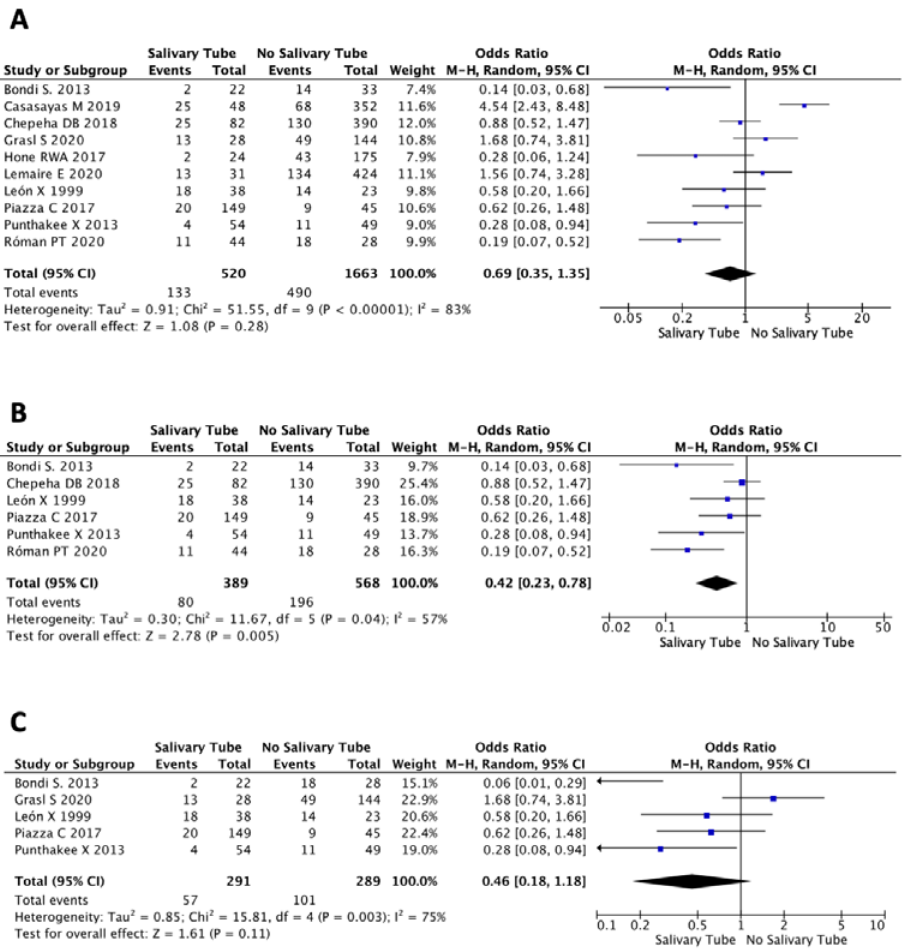
Figure 3. Meta-Analysis-Salivary Tube and Pharyngocutaneous Fistula. ( A ) Meta-Analysis was performed with 10 studies providing data of use or non-use of salivary bypass tube in patients after larygnectomy and laryngopharyngectomy. ( B ) An additional meta-analysis was performed solely with 6 out of these 10 studies who have applied salivary bypasst tube in more than 20% of cases. ( C ) Finally, we performed a meta-analysis with 5 studies providing data of salivary bypass tube application solely in cases with